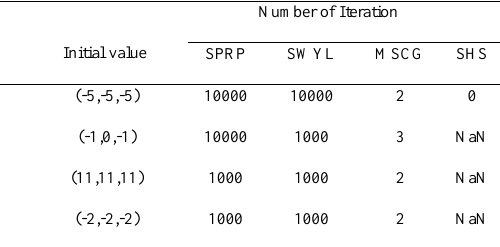
Table 3. Numerical Results for SPRP, SWYL, MSCG and SHS Methods based on Number of Iterations.